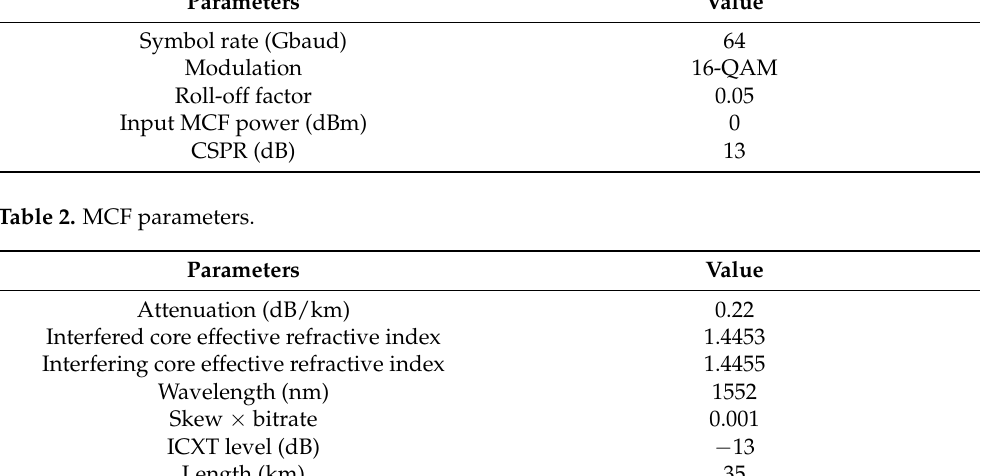
Table 1. Signal parameters.